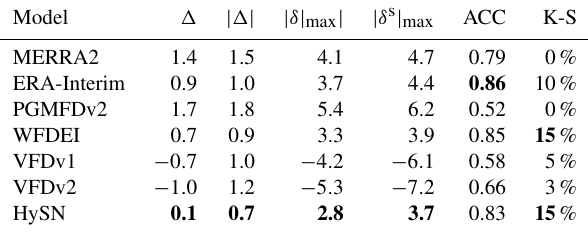
Table 3. Summary of metrics showing the humidity estimates’ similarity to station observations. Differences ( (cid:49) ) are given in dew point temperature in degrees Celsius. (cid:49) is the mean station difference, | (cid:49) | is the mean absolute station difference, | δ max | is the largest absolute difference at any station, while | δ s | max is the largest seasonal difference at any station. ACC is the anomaly (de- seasonalized) daily correlation coefficient, while K-S indicates the number of stations where the daily mean cumulative distribution passes the Kolmogrov–Smirnov test of similarity ( p > 0 . 001). The best scores are shown in